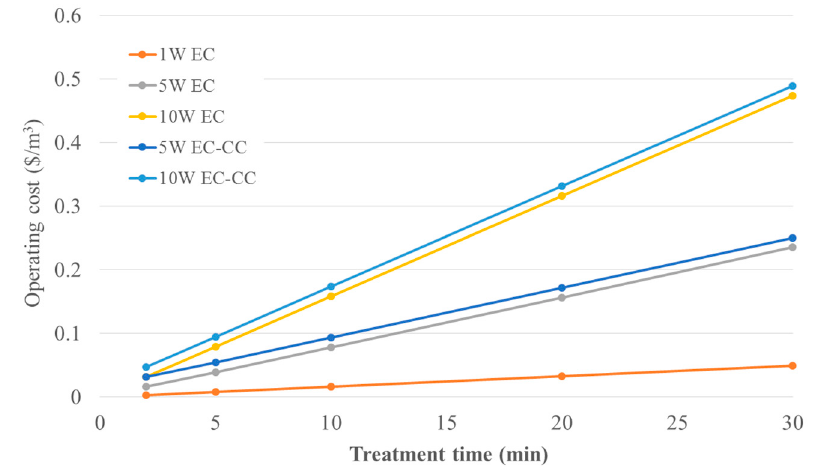
Figure 7. Comparison of operating costs for EC and EC-CC at 1 W, 5 W, and 10 W as a function of treatment time.